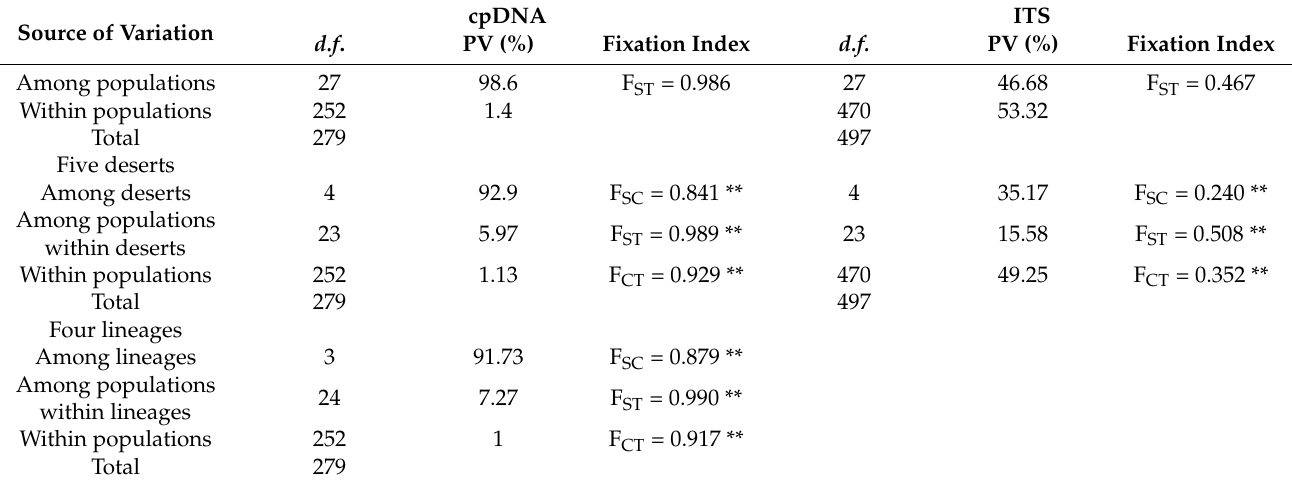
Table 3. Hierarchical analysis of molecular variance (AMOVA) based on chloroplast DNA (cpDNA) and internal transcribed spacer (ITS) data of 280 individuals from 28 Stilpnolepis centiflora